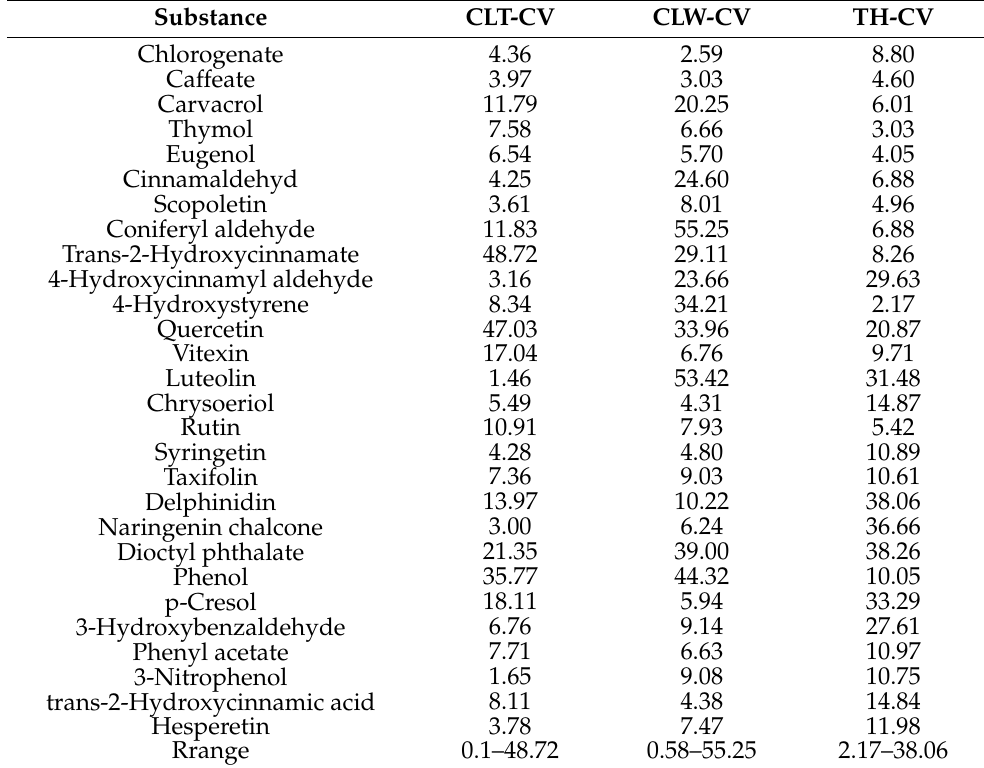
Table A2. Coefficient of variation (CV) for CLT, CLW, and TH.